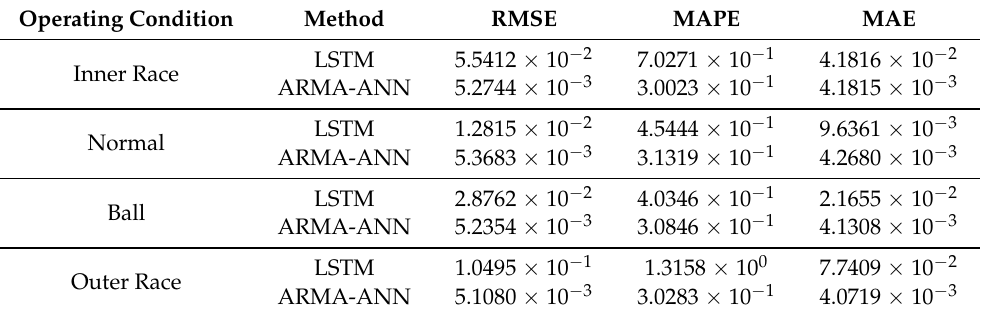
Table 6. Comparison of performance criteria of prediction results for ARMA-ANN and